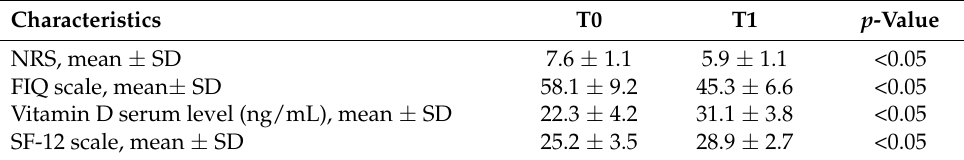
Table 2. Effects of vitamin D supplementation at 3 months in group A.